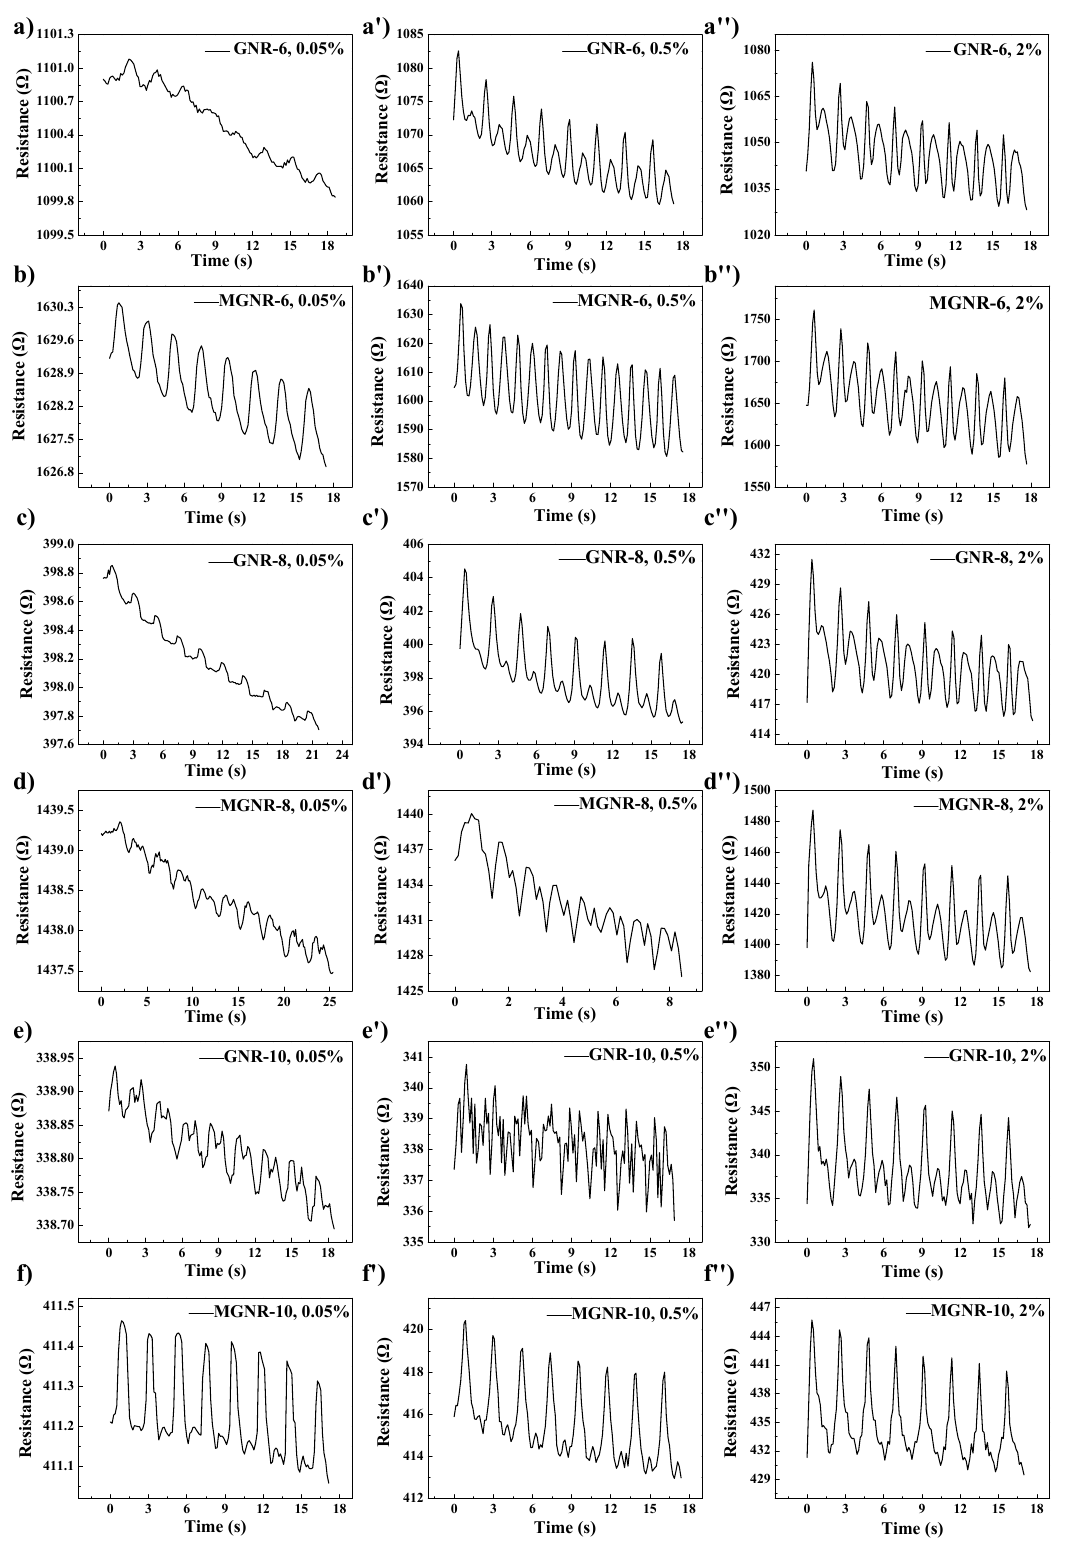
Figure 10. The change of resistance for the cyclic stretching in ( a ) GNR-6; ( b ) MGNR-6; ( c ) GNR-8; ( d ) MGNR-8; ( e ) GNR-10; and ( f ) MGNR-10 for different strain.